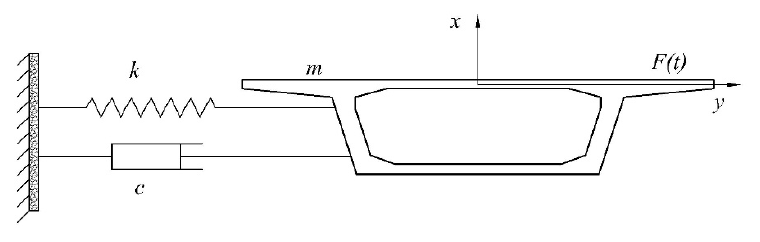
Figure 1. The mass–spring–damper system.